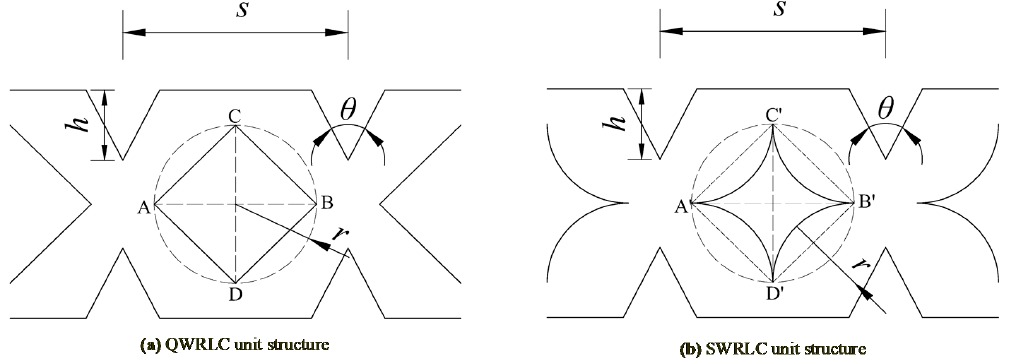
Figure 8. Schematic diagrams of two structural improvements.